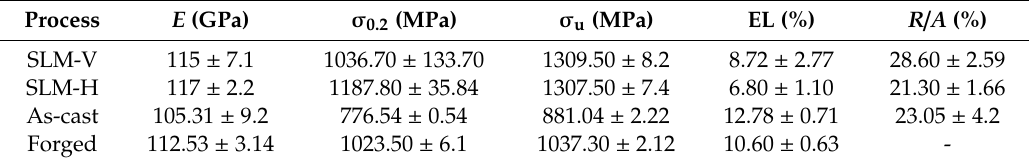
Figure 4. The ( a ) as-cast and ( b ) as-forged microstructure of the Ti–6Al–4V alloy. Table 1. The mechanical properties at room temperature of the Ti–6Al–4V alloy produced by SLM and traditional processes.